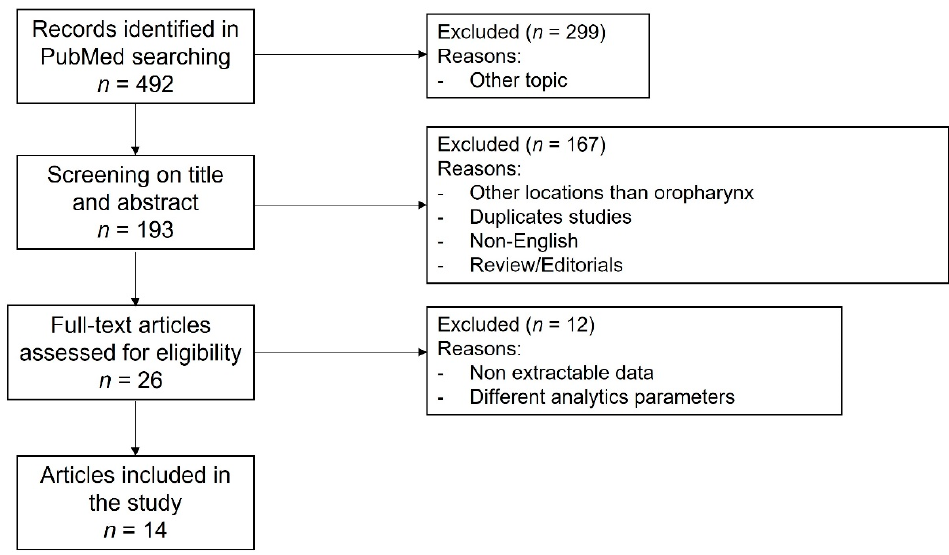
Figure 1. Flow chart showing the process of the study selections for the systematic